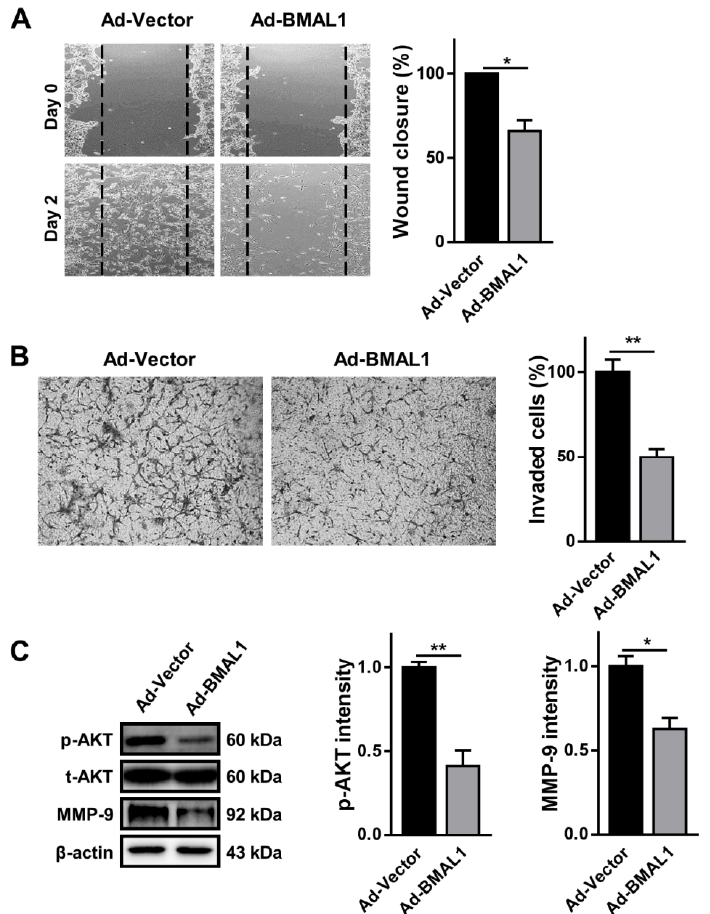
Figure 7. Cell migration and invasion are decreased in U87MG cells with overexpression of BMAL1. ( A ) At 48 h post-infection with control or BMAL1 adenovirus in U87MG cells, the near-confluent cell culture was scratched with a 20 μl tip at the center of wells. Migration was expressed as a percentage of wound closure at 48 h after scratching. Data are expressed as the mean ± SEM (one-way ANOVA test, * p < 0.05 vs. NC, three independent experiments). ( B ) Invaded cells infected with control and BMAL1 viruses were analyzed. Data are expressed as the mean ± SEM (Student’s t -test, ** p < 0.01 vs. Ad-vector, three independent experiments). ( C ) Expression levels of p-AKT and MMP-9 in U87MG cells infected with control and BMAL1 viruses were examined by Western blot. Data are expressed as the mean ± SEM (Student’s t -test, * p < 0.05 and ** p < 0.01 vs. Ad-vector). In addition, we carried out the Matrigel invasion assay using control or BMAL1 virus-infected U87MG cells to measure invasiveness. The number of cells that penetrated the pores of the membrane was decreased by approximately 50% in BMAL1-overexpressing U87MG cells compared with control cells (Ad-vector 70.01 ± 1.23 vs. Ad-BMAL1 35.55 ± 1.77) (Figure 7B). Similarly, the levels of MMP-9 in BMAL1-overexpressing cells decreased by approximately 33%, compared with control cells (Ad-vector 75.17 ± 4.43 vs. Ad-BMAL1 50.44 ± 7.58) (Figure 7C). Altogether, the loss of migration and invasion in ectopic BMAL1-expressing U87MG cells might be related with the downregulation of p-AKT and MMP-9. 3. Discussion